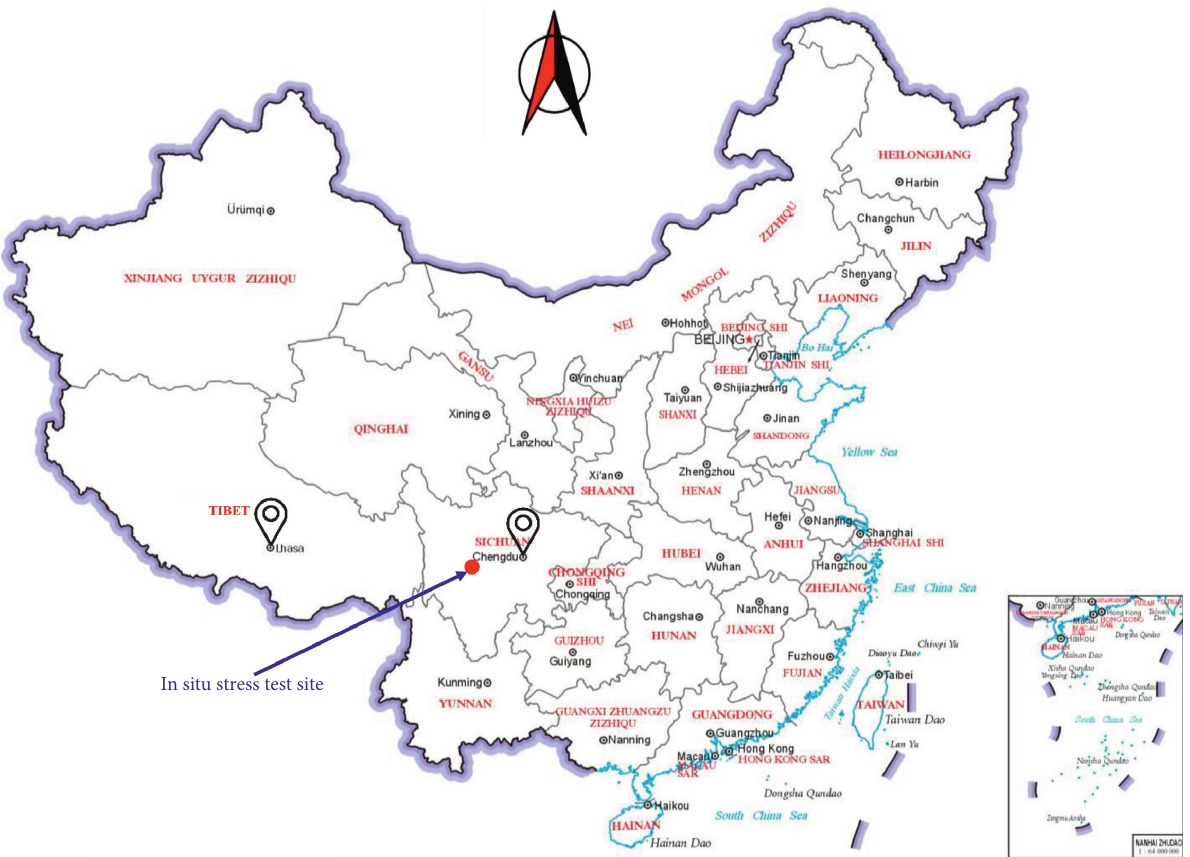
Figure 1: Geological location map of in situ stress test site.